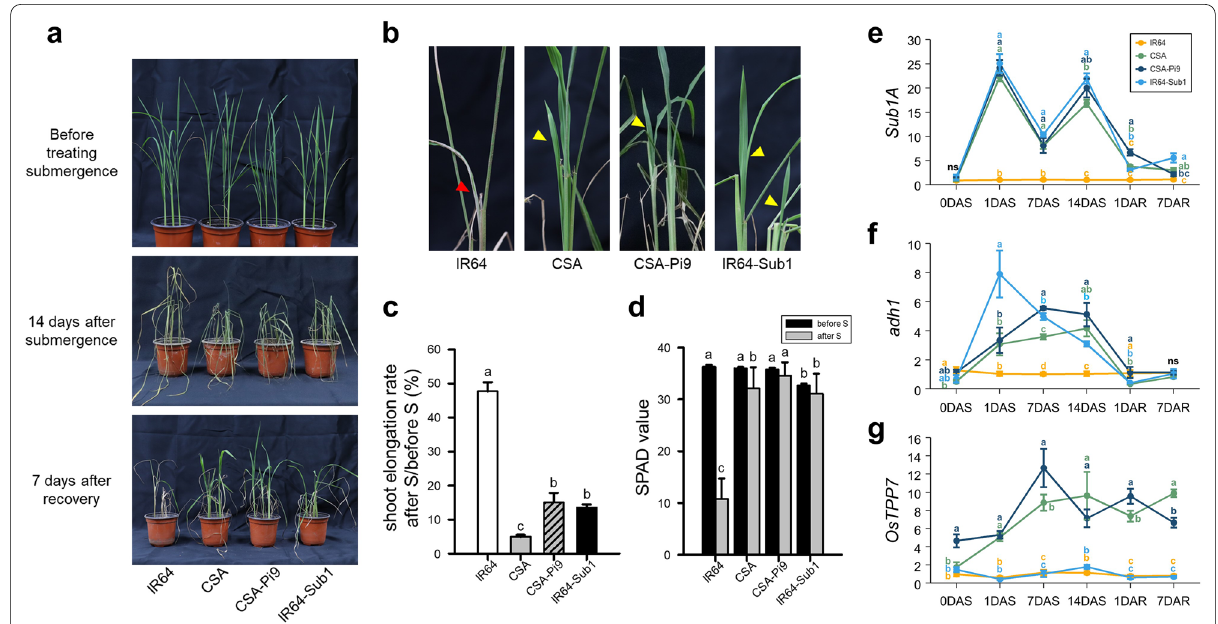
Fig. 4 Characterization of the CSA‑Pi9 breeding line treated with submergence stress for 14 days. Growth phenotype of CSA‑Pi9 and other genotypes during submergence stress ( a ) and at 7 days after de‑submergence ( b ). Shoot elongation rate [calculated as (shoot height after submergence (S)/shoot height before S) 100] ( c ) and SPAD value ( d ) of CSA‑Pi9 before and after submergence. Expression levels of Sub1A ( e ), adh1 × ( f ) and OsTPP7 ( g ) under submergence stress. Data represent mean standard error (SE). Lowercase letters above bars and lines indicate statistically ± significant differences ( P < 0.01; Duncan’s multiple range test). IR64: submergence susceptible variety; IR64‑Sub1: submergence tolerant variety; yellow arrow: newly emerging leaves; red arrow: no new leaves; DAS: days after submergence; DAR: days after